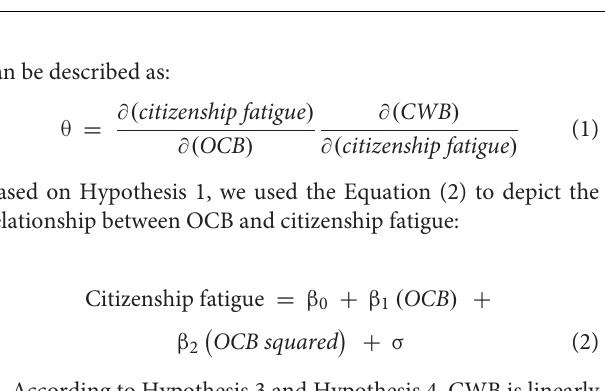
FIGURE 2 | The moderating role of POS on the relationship between OCB and citizenship